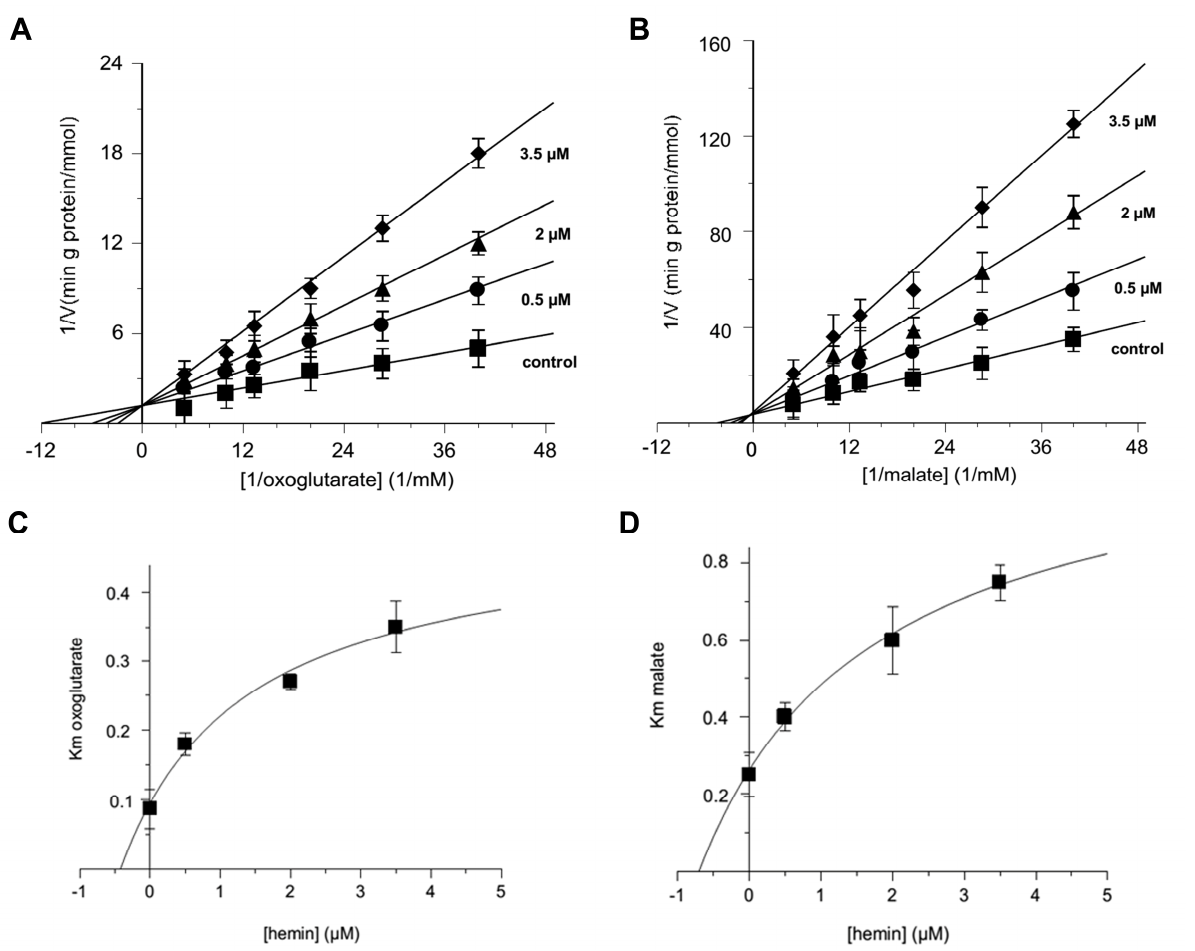
Figure 1. Double reciprocal plots of the 2-oxoglutarate and malate transport activity in presence of external hemin, and second-order graphs. Double reciprocal plots show the dependence of the uptake rate by external concentrations of hemin. The transport rates of [ 14 C] 2-oxoglutarate ( A ) and [ 14 C] malate ( B ) in proteoliposomes containing 6 mM of 2-oxoglutarate were measured in 2 min in the absence ( ■ ) or presence of hemin at 0.5 μM (●), 2 μM ( ▲ ), or 3.5 μM ( ). Hemin was added along with [ 14 C] 2-oxoglutarate ( A ) and [ 14 C] malate ( B ) at concentrations ranging from 0.025 mM to 0.2 mM. The data are displayed as the means ± SD of three different experiments. The R 2 calculations obtained using a linear regression model for the straight lines of ( A ) were equal to 0.997 in the absence ( ■ ) of hemin, and equal to 0.997, 0.995, and 0.952 in presence of hemin at 0.5 μM (●), 2 μM ( ▲ ), and 3.5 μM, respectively. The R 2 calculations obtained using a linear regression model for the straight lines of ( B ) were equal to 0.988 in the absence ( ■ ) of hemin, and equal to 0.982, 0.998, and 0.913 in presence of hemin at 0.5 μM (●), 2 μM ( ▲ ), and 3.5 μM, respectively. Panel ( C , D ): Second-order graphs report the Km’s values obtained from ( A ) (R 2 = 0.962) and ( B ) (R 2 = 0.990) versus hemin